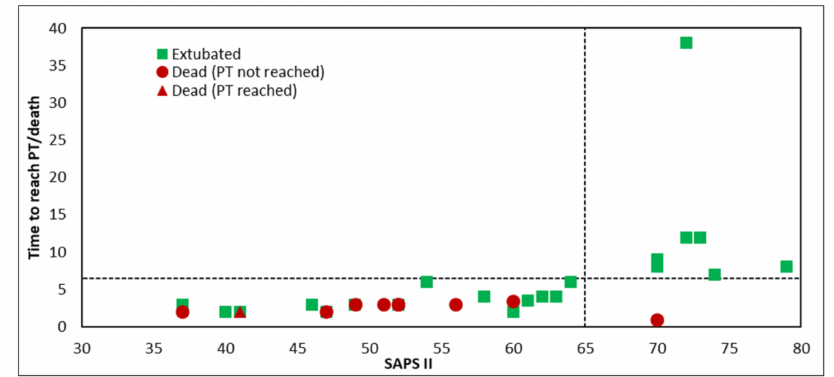
Figure 6. Association between SAPS II score and time to reach protein target